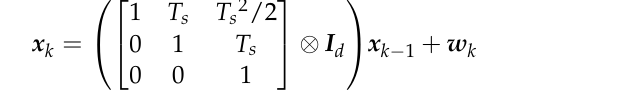
Figure 10. The average OSPA of different filters in example 1 (CV motion model) for 100 sample runs, when T s = 2 s ( T i = 4 ms, λ = 52, p D , k = 0.96). ( a ) Average OSPA distances of different filters. ( b ) OSPA locations of different filters. ( c ) OSPA cardinalities of different filters.